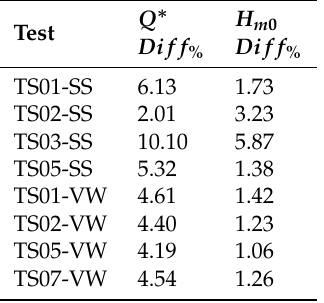
Table 2. Percentage difference in H m 0 and Q ∗ for non-random seeding